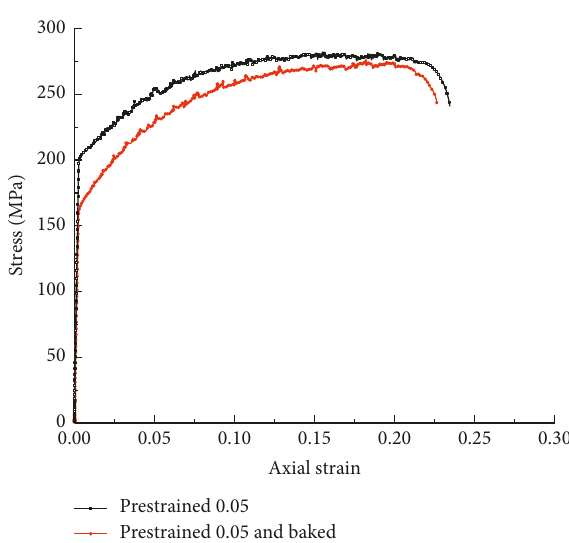
Figure 11: Comparison of lap-shear tests of SPR and clinched joints before and after the baking process at 0.083 × 10 − 3